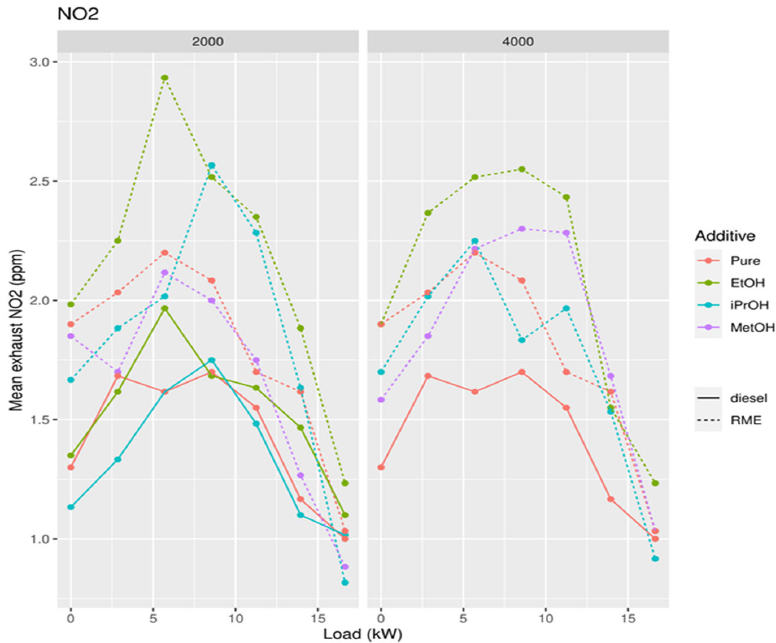
Figure 12. Concentration of NO 2 in exhaust gases in function of the power of the diesel generator after addition of 2000 and 4000 ppm of methanol, ethanol, and isopropanol to biodiesel.